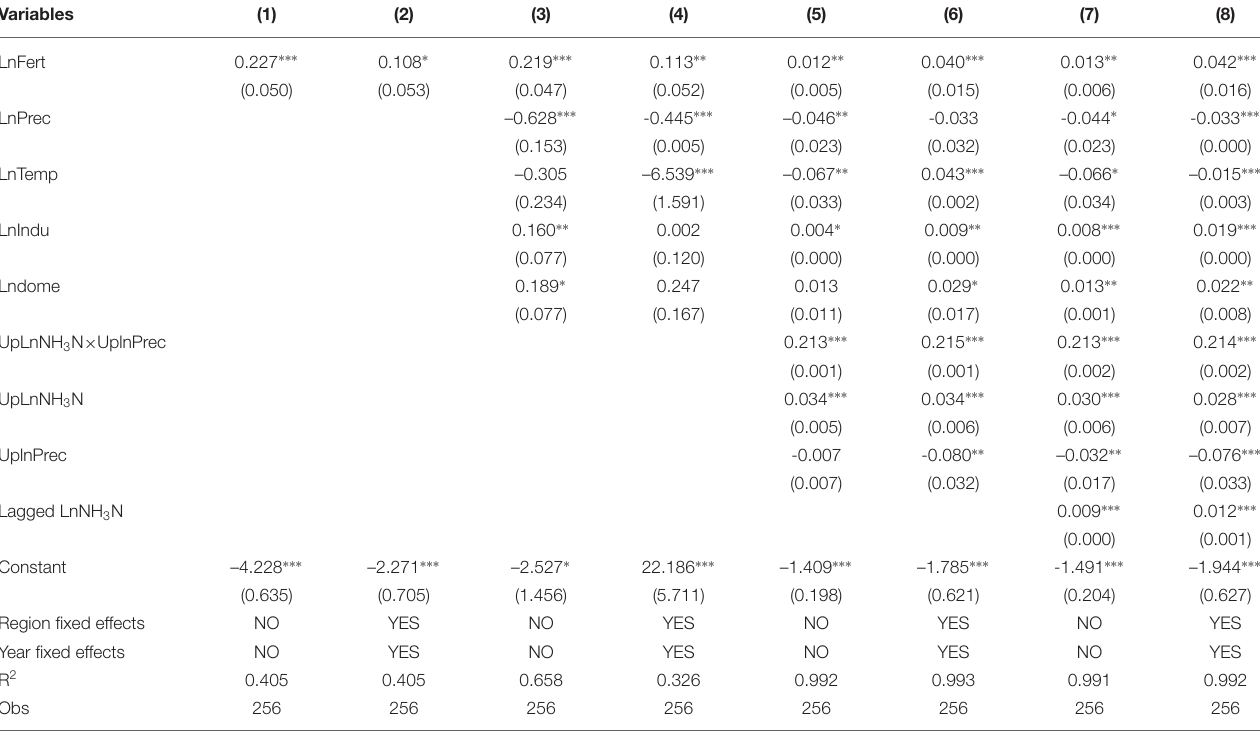
TABLE 2 | Estimation results of the impact of different pollution sources on water quality.